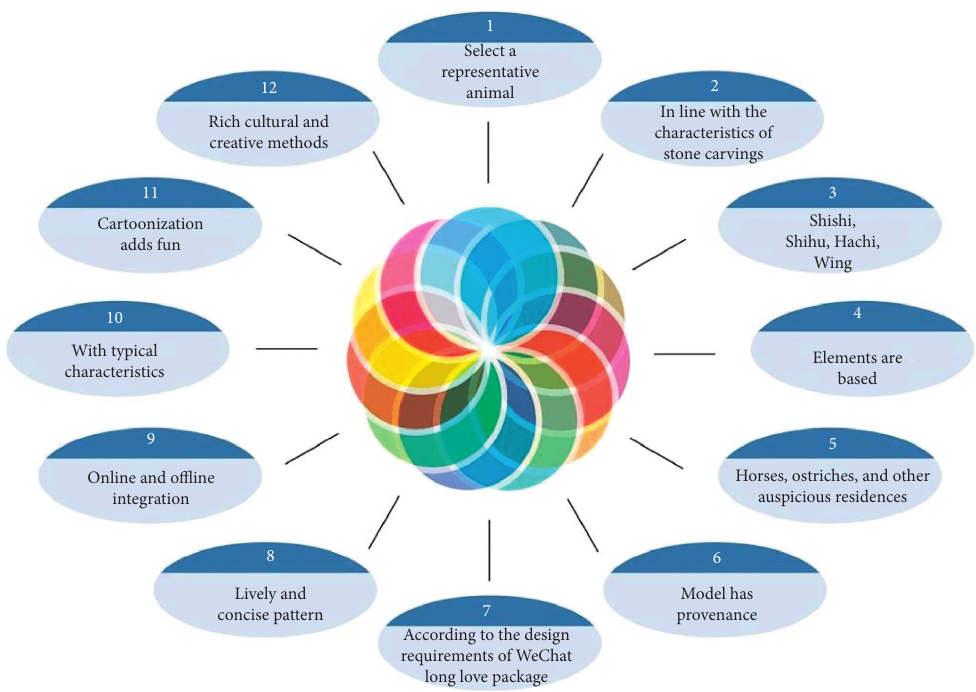
Figure 2: Design idea